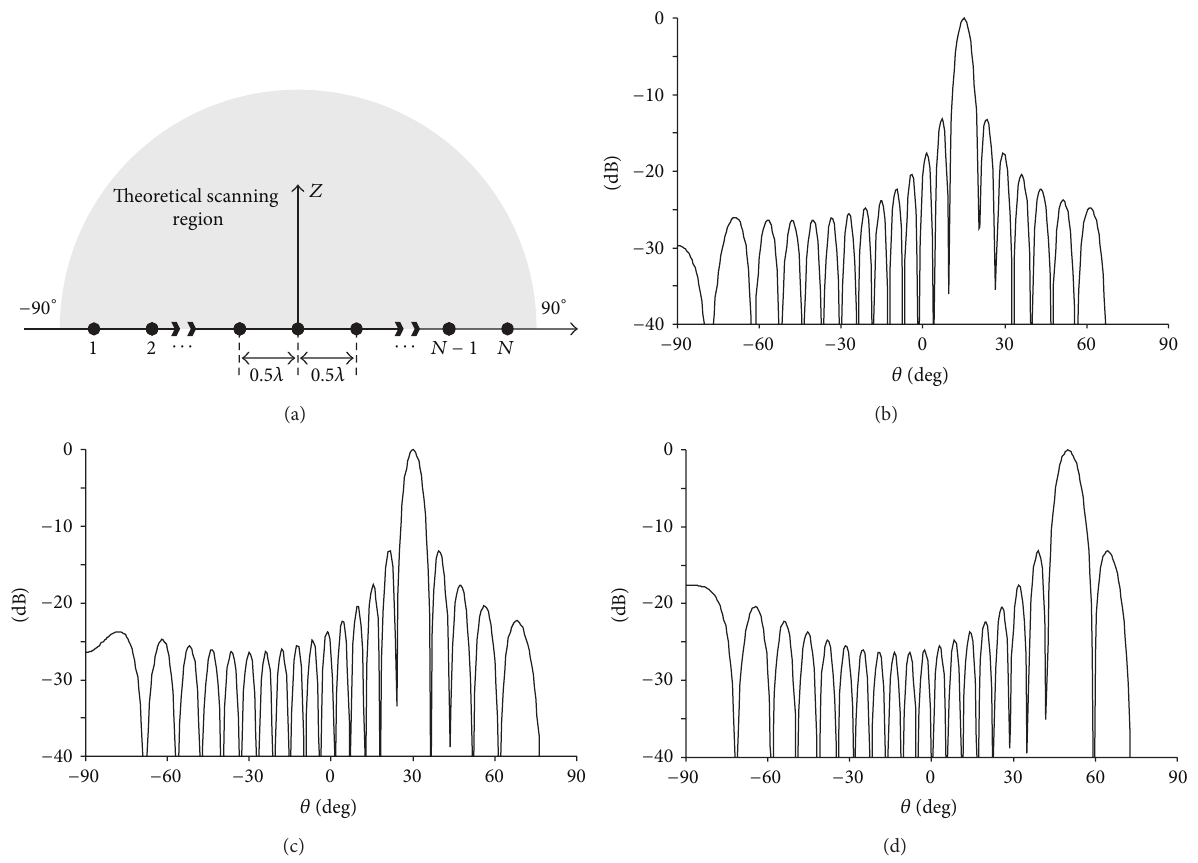
Figure 3: Scanning performances of an N -elements linear array with spacing equal to 0.5𝜆 : (a) allowable scanning area given by relation (1); (b) array factor for a scan angle 𝜃 𝑠 = 15 ∘ and 𝑁 = 21 ; (c) array factor for a scan angle 𝜃 𝑠 = 30 ∘ and 𝑁 = 21 ; (d) array factor for a scan angle = 50 ∘ and 𝑁 = 21 . 𝜃 𝑠